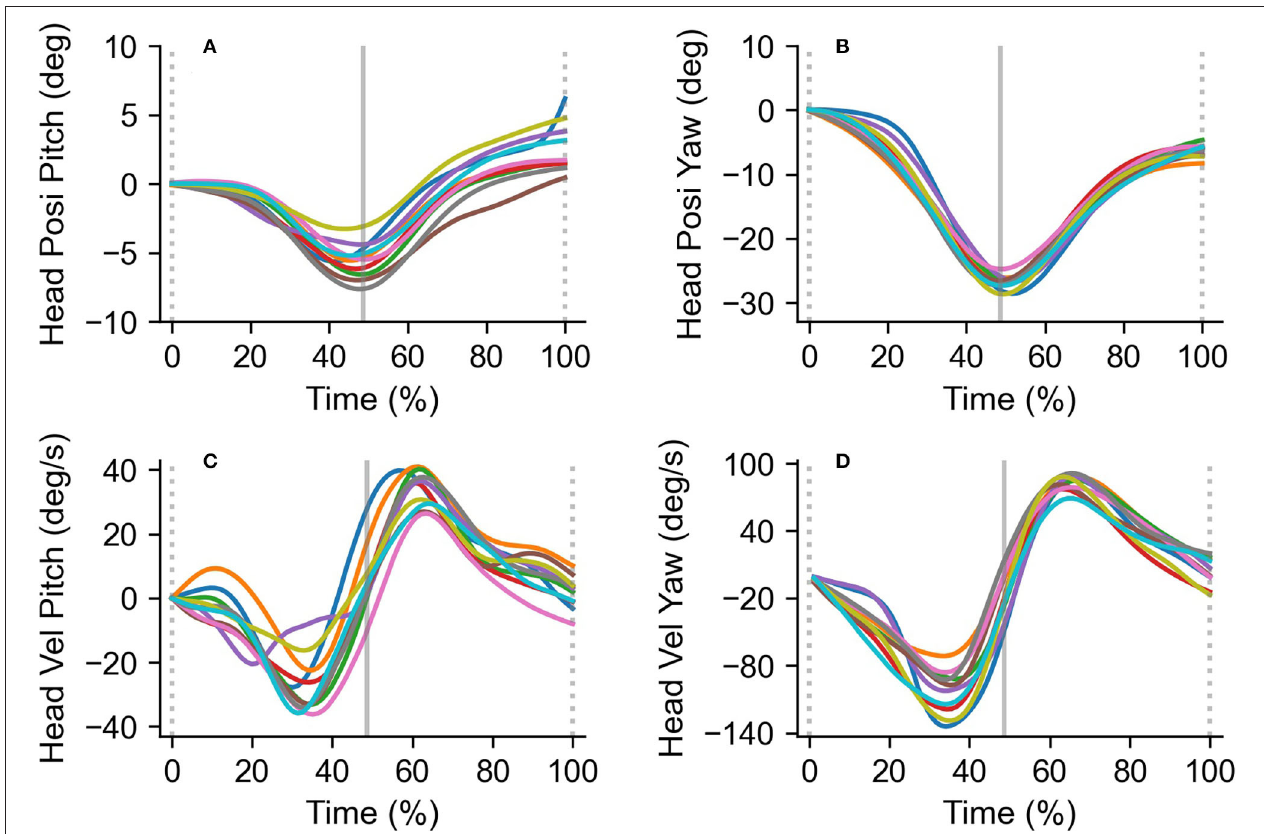
FIGURE 3 | Typical head angular position and velocity traces in the pitch (left column) and yaw (right column). Head angular position in the pitch (A) and yaw (B) , and head angular velocity in the pitch (C) and yaw (D) axes are shown. All traces were obtained from a single trial (10 rallies a trial). The broken lines indicate the time when the experimenter hits the ball, and the vertical solid lines indicate the time when the participant hits the ball. The downward and upward velocity phases correspond to the ball tracking and hitting phases, respectively. Upward deflections indicate upward or leftward